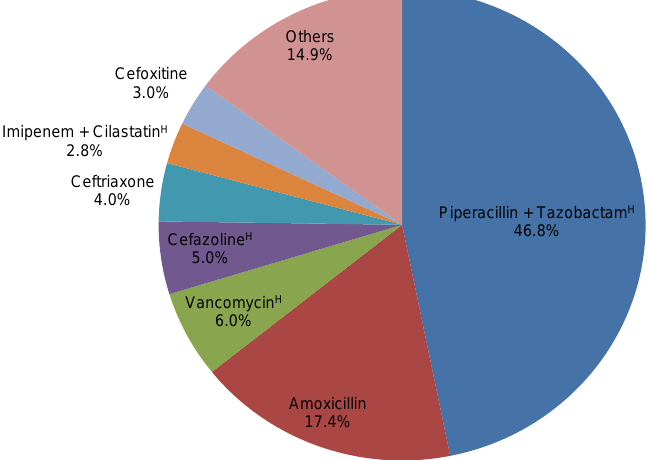
Figure 2. Distribution of the most used antibiotics within the hospital care sector in the studied years of 2010 and 2011 ( H , Hospital exclusive